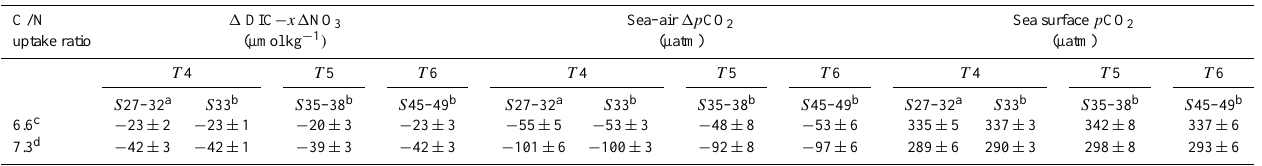
Table 3. Values of sea–air (cid:49)p CO 2 and sea surface p CO 2 estimated with different (cid:49) DIC − x(cid:49) NO 3 . The variable x denotes the C/N uptake ratio during organic carbon production. T and S represent transect and station(s).